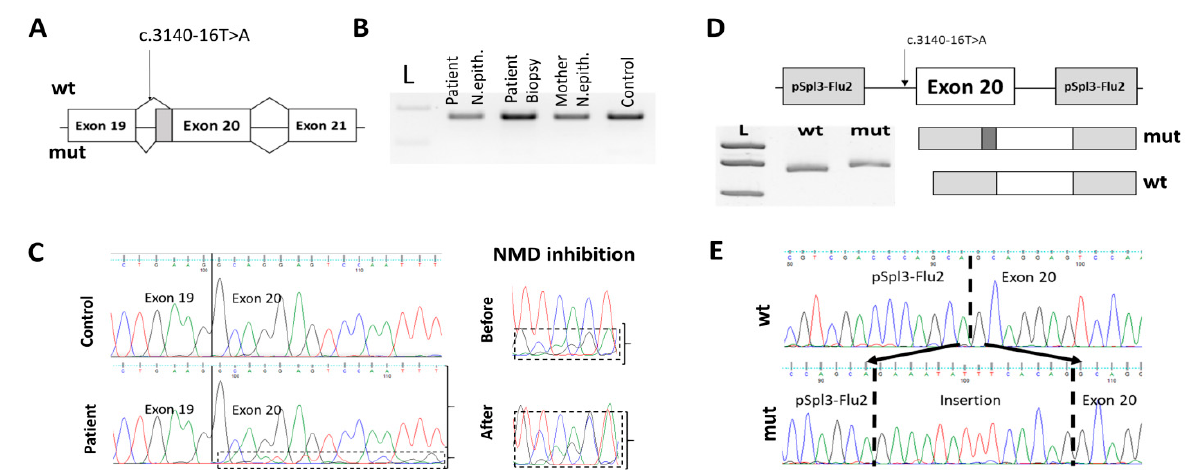
Figure 5. RT-PCR and minigene analysis of c.3140-16T>A. ( A ) Scheme of the locus containing c.3140-16T>A and expected splicing products. ( B ) Electrophoregram of RT-PCR products. ( C ) Sequencing of RT-PCR products. The dashed line outlines the mutant isoform of exon 20. ( D ) Scheme of the minigene construct and PAGE of RT-PCR fragments obtained from the wild type and mutant minigene. ( E ) Sequencing of minigene products.